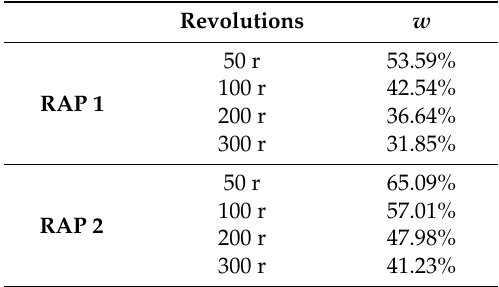
Table 1. The Stability Index ( w ) of Two Kinds of RAP